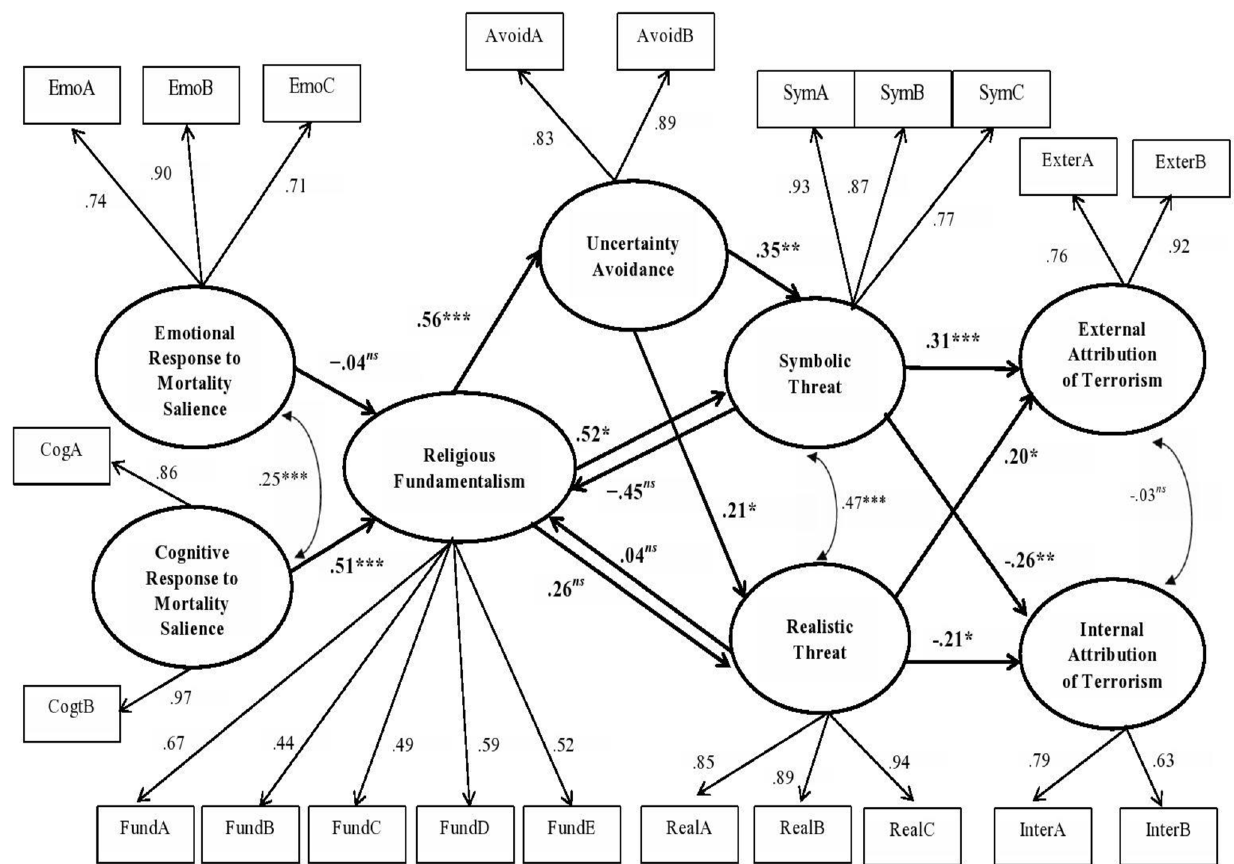
Figure A.3. The Alternative Model 2 by assuming the bidirectional relationships among religious fundamentalism, symbolic threat, and realistic threat. Note. The numbers were standardized path coefficients and factor-loadings. ExterA−ExterB = External Attribution of Terrorism Parcel A and Parcel B; InterA−InterB = Internal Attribution of Terrorism Parcel A and Parcel B; SymA−SymC = Symbolic Threat Parcel A, parcel B, and Parcel C; RealA−RealC = Realistic Threat Parcel A, parcel B, and Parcel C; AvoidA−AvoidB = Uncertainty Avoidance Parcel A and Parcel B; FundA−FundE = Religious Fundamentalism Parcel A, Parcel B, Parcel C, Parcel D, and Parcel E; EmoA−EmoC = Emotional Response to Mortality Salience Parcel A, Parcel B, and Parcel C. CogA-CogB = Cognitive Response to Mortality Salience Parcel A and Parcel